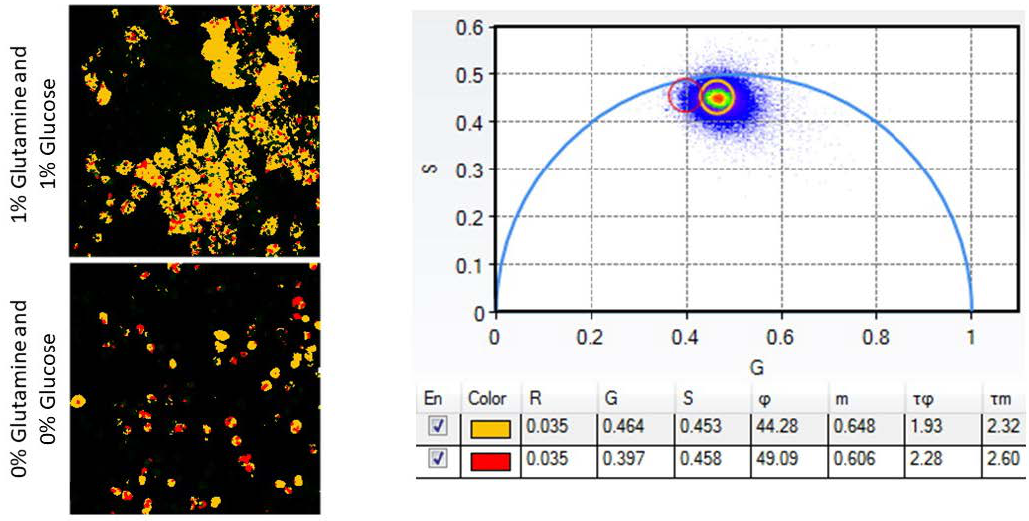
2 of 11 Figure 1. Schematic representation of the LSS-mOrange-DEVD-mKate2 reporter. The intact DEVD linker between LSS-mOrange and mKate2 causes the two fluorescent proteins to be spatially close and experience increased FRET. This increase in FRET causes a decrease in the donor (LSS-mOrange) lifetime. Once the DEVD linker is enzymatically cleaved by active caspase-3, LSS-mOrange and mKate2 can spatially separate. This causes FRET to decrease and the donor (LSS-mOrange) lifetime to increase. In Protocols 2 and 4, we discuss multiple experimental setups and imaging protocols, respectively. We expect the LSS-mOrange control cells to display a longer fluorescence lifetime than cells expressing fused LSS-mOrange-DEVD-mKate2 due to the lack of energy being transferred from the donor protein. Any treatment that causes apoptotic cell death will display an increased fraction